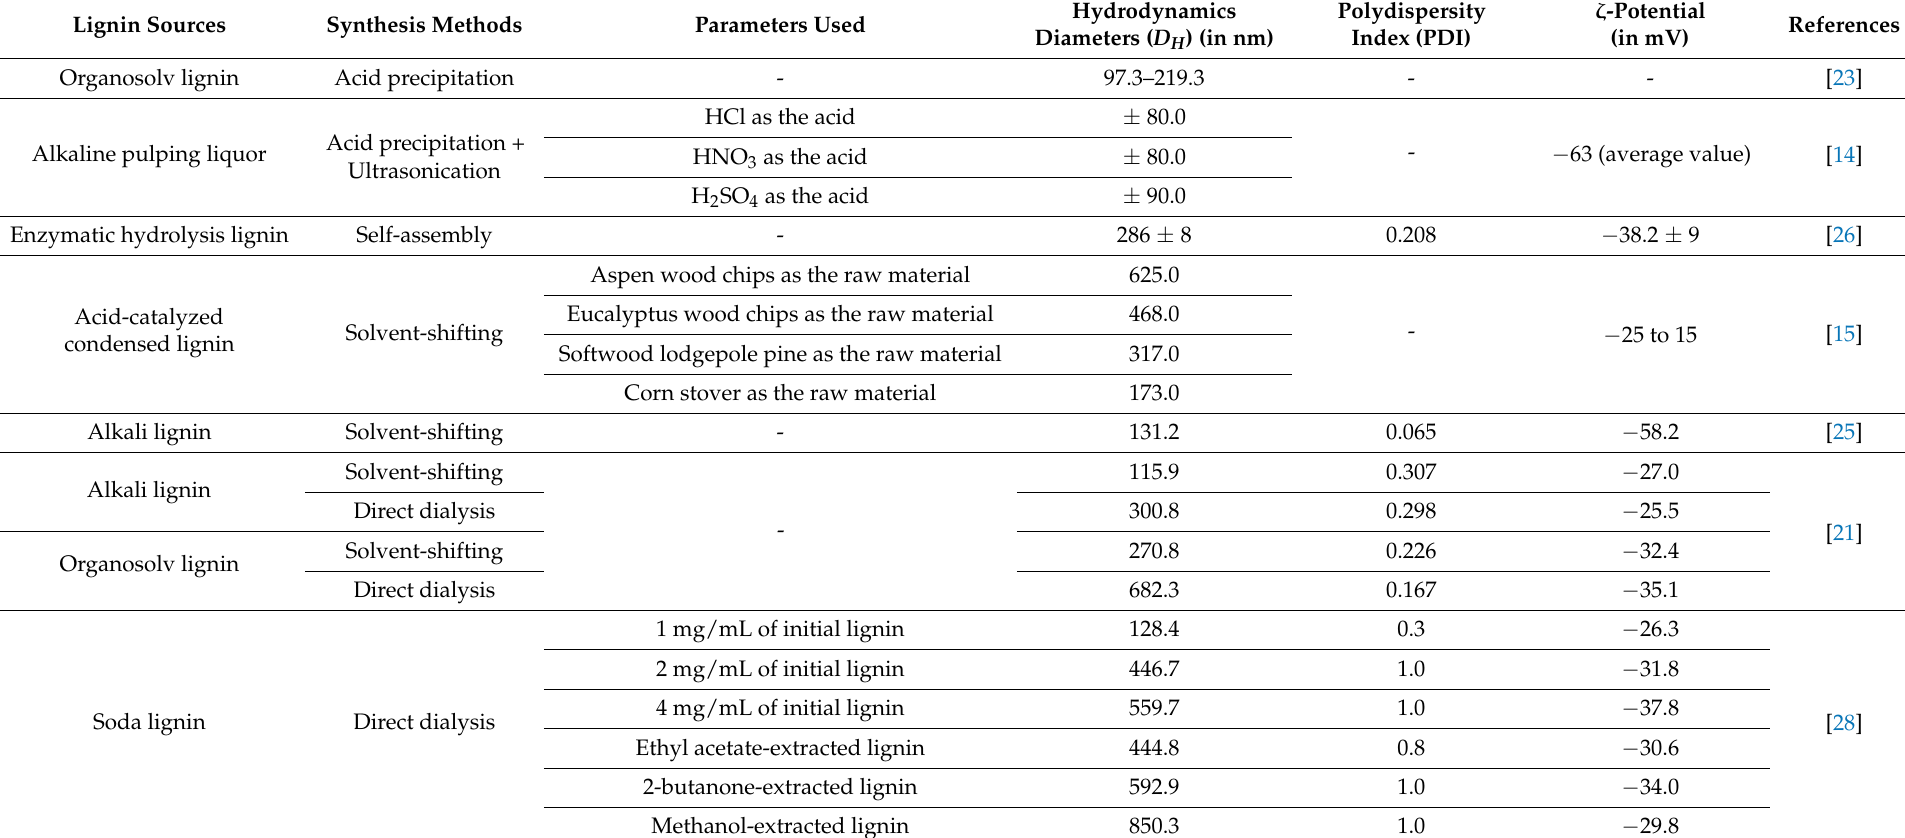
Table 2. Previous studies of LNPs synthesis using various lignin sources and synthesis